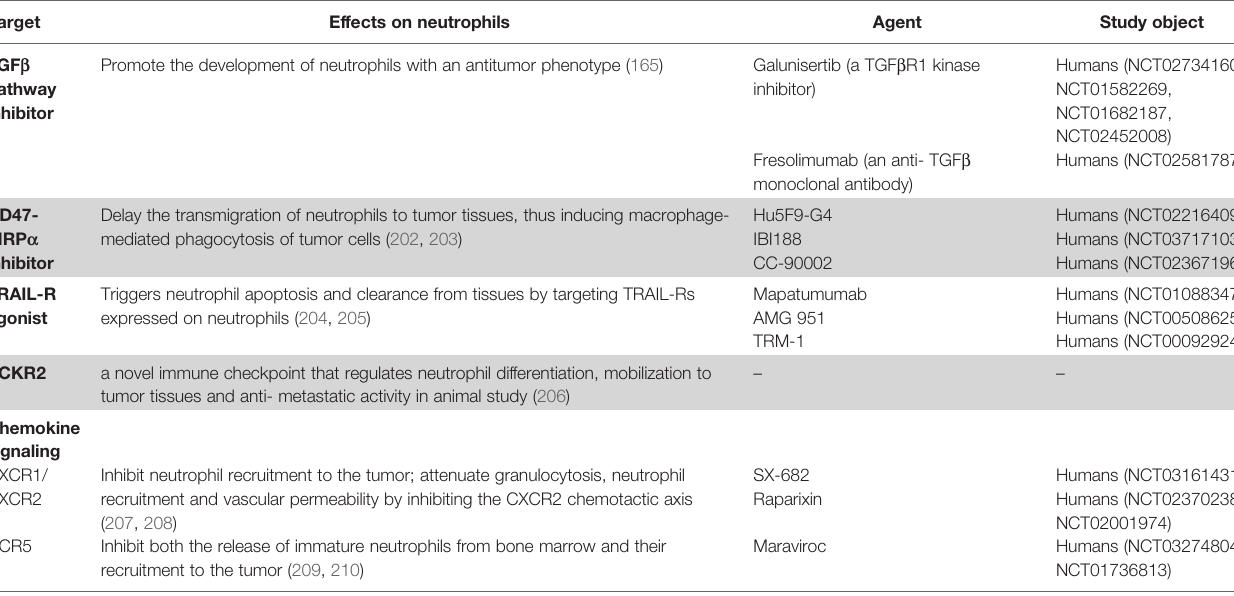
TABLE 1 | Agents with putative effects on neutrophils in patients with